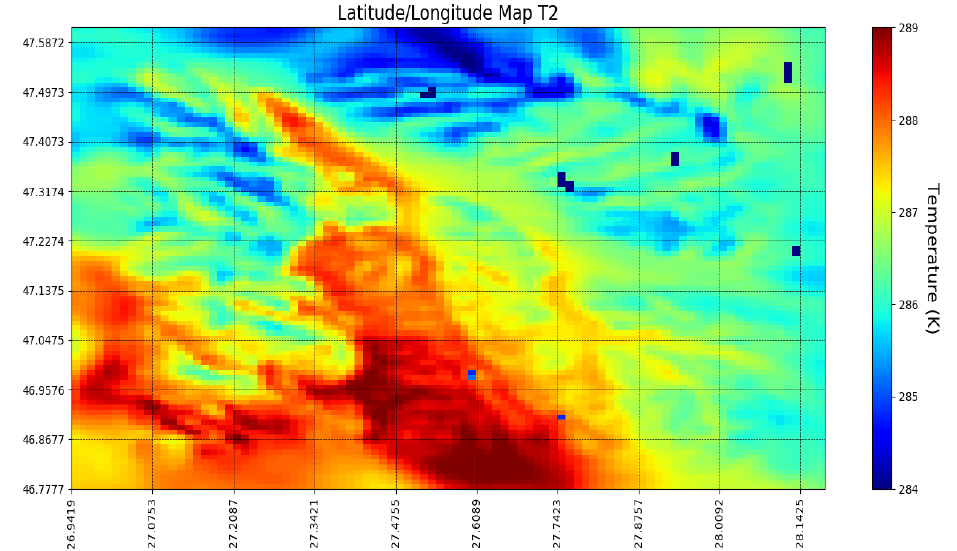
Figure 6. Example of a WRF output map (temperature at 2 m AGL); 3rd nest, in center of nest: Ia și ; 04/04/2016, 08:00 UTC; YSU parametrization.